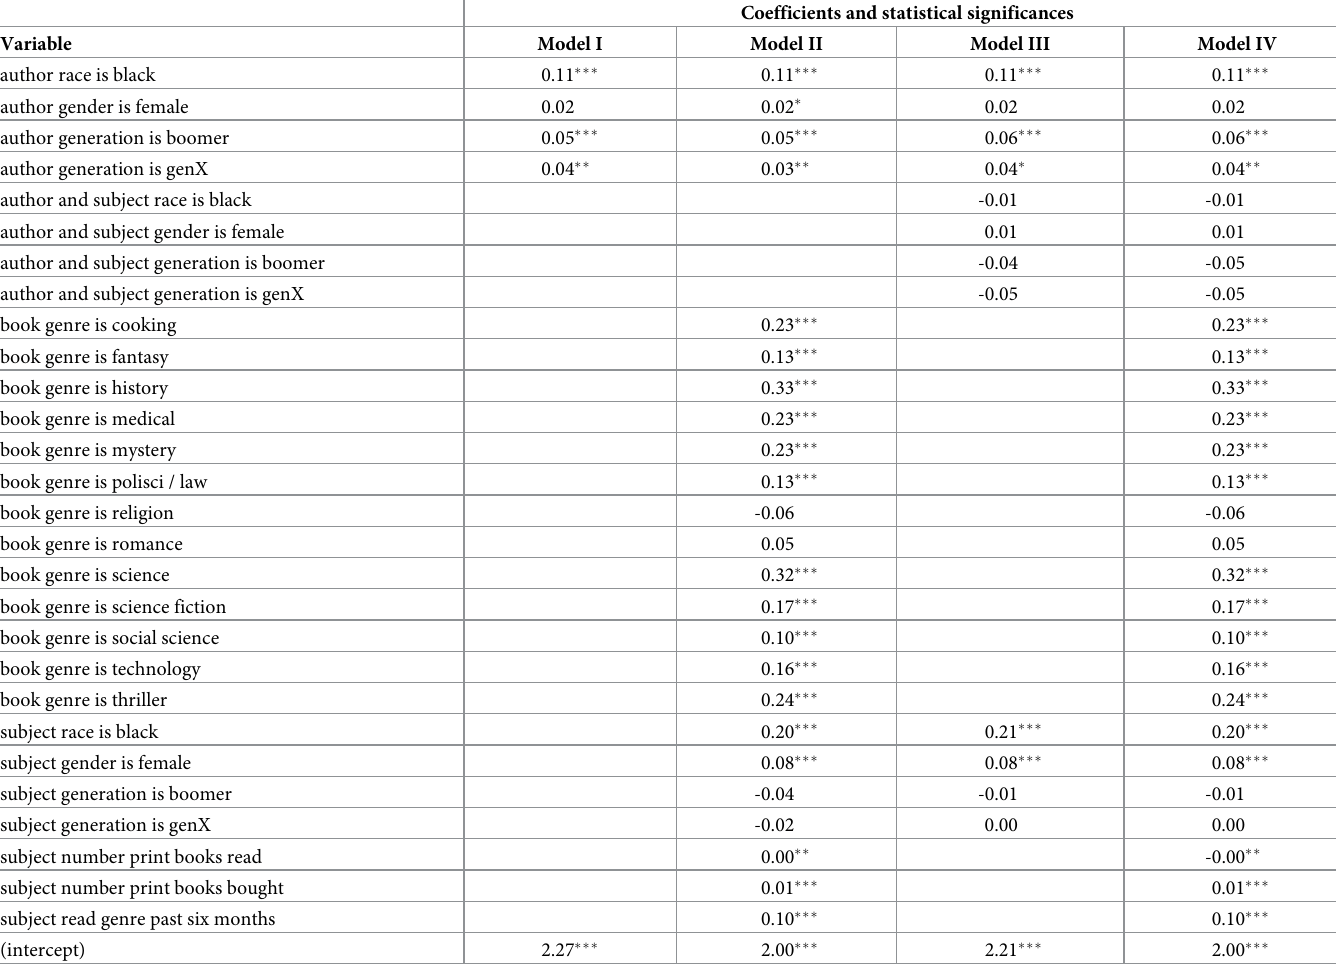
Table 6. Rating of author qualification in the surveyed